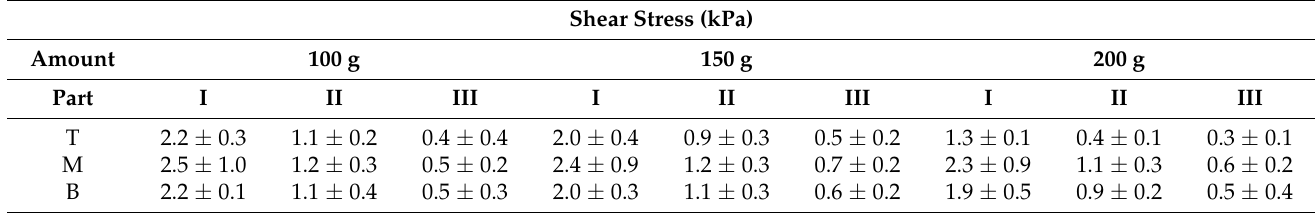
Table 3. Shear stress (kPa) measured by the cutting test of sterilized BF. T, M, and B correspond to the top, middle, and bottom, respectively, in Figure 2b for the sampling location in a stand-up pouch. Shear Stress